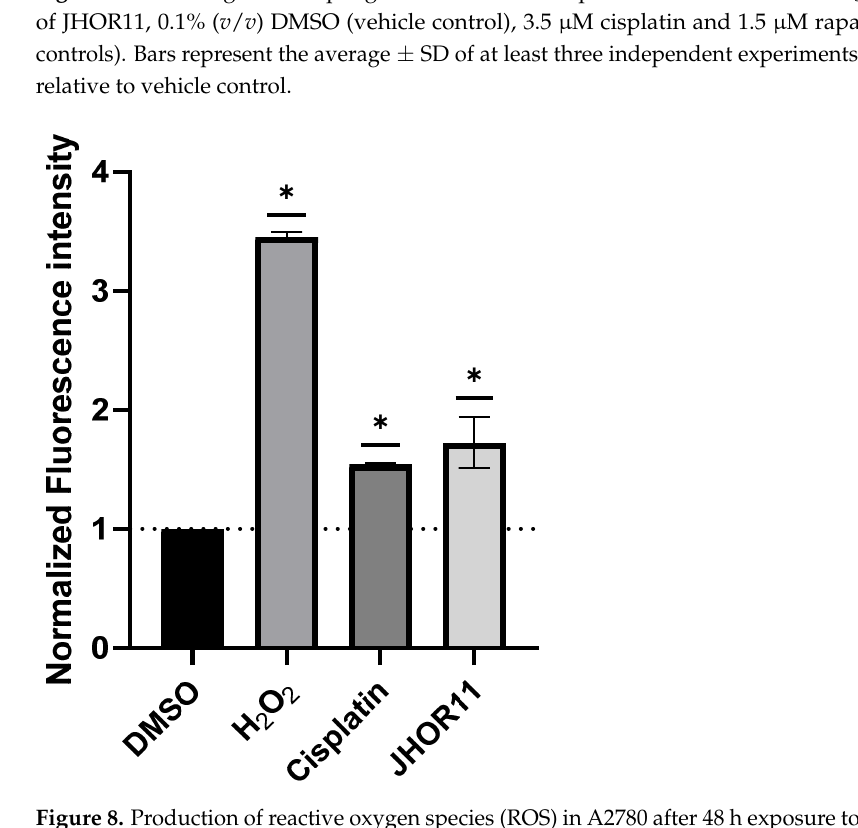
Figure 8. Production of reactive oxygen species (ROS) in A2780 after 48 h exposure to IC 50 of com- plex JHOR11, 0.1% ( v / v ) DMSO for vehicle control, 25 μ M H 2 O 2 and 3.5 μ M cisplatin as positive controls. Bars represent the average ± SD of at least three independent experiments of the fluores- cence intensity normalized to fluorescence intensity of the vector control, represented as a dotted line. * p value < 0.05.